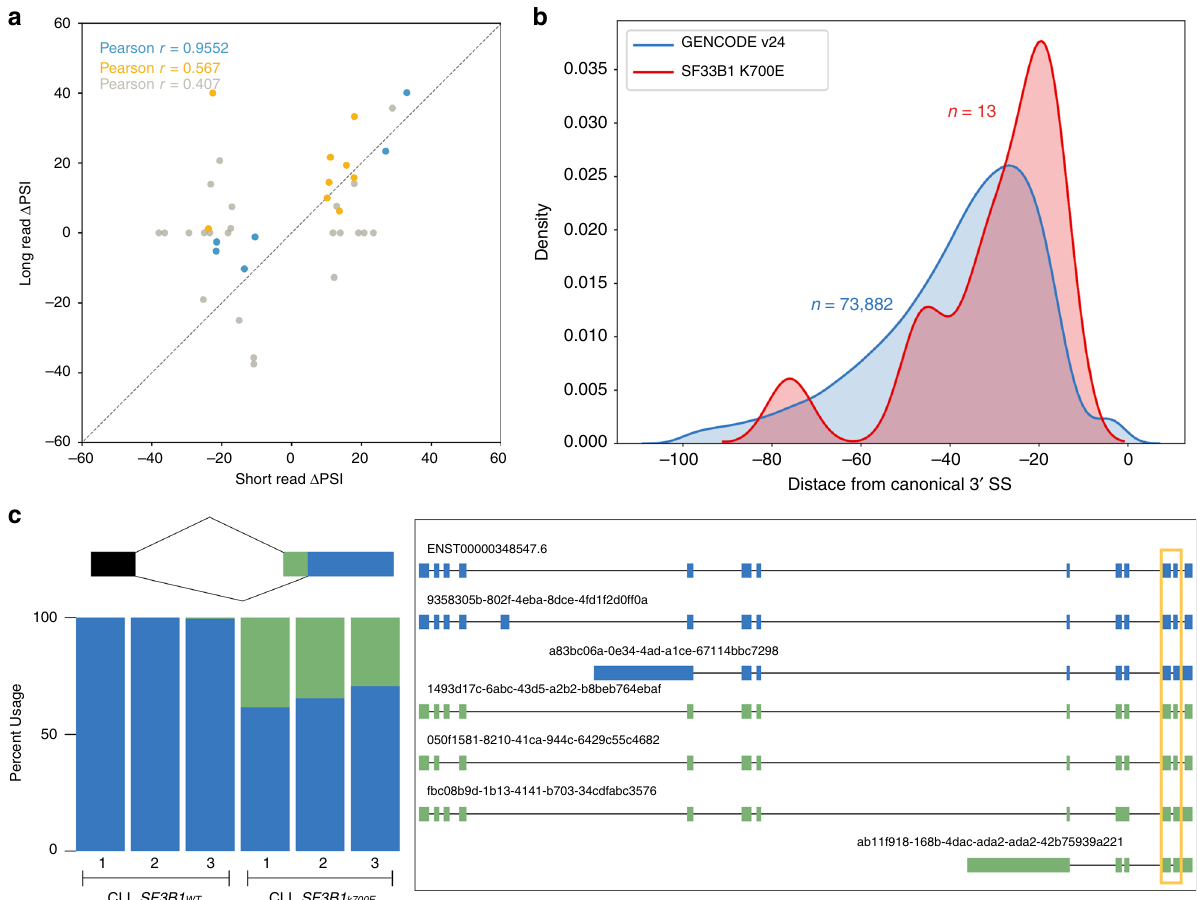
Fig. 3 Alternative 3 ′ splicing patterns identi fi ed with nanopore-sequencing data are concordant with short read data and reveal additional splicing complexity. a Comparison of the delta PSI for signi fi cant alternative splicing events identi fi ed by juncBASE using short-read data and the median delta PSI of the same events using long-read data. The colors correspond to the median coverage of the splice junctions, where blue is greater than 25 reads, yellow is greater than 10, and gray is greater than 0. b Distribution of proximal splice sites found in nanopore reads for 13 signi fi cant sites (corrected p value < 0.10, delta PSI > 10). The GENCODE distribution is the distribution of distances from canonical 3 ′ splice sites to the nearest non-GAG trimer. Source data are provided in a Source Data fi le. c ERGIC3 splice-site usage (left) and full isoforms (right) for the proximal chr20:35,556,954 (green) and distal chr20:35,556,972 (blue) sites from 5 ′ to 3 ′ . The dominant isoforms using either the proximal or distal site are 1493d17c-6abc and ENST00000348547.6. The alternative acceptor event is boxed in yellow in the isoform